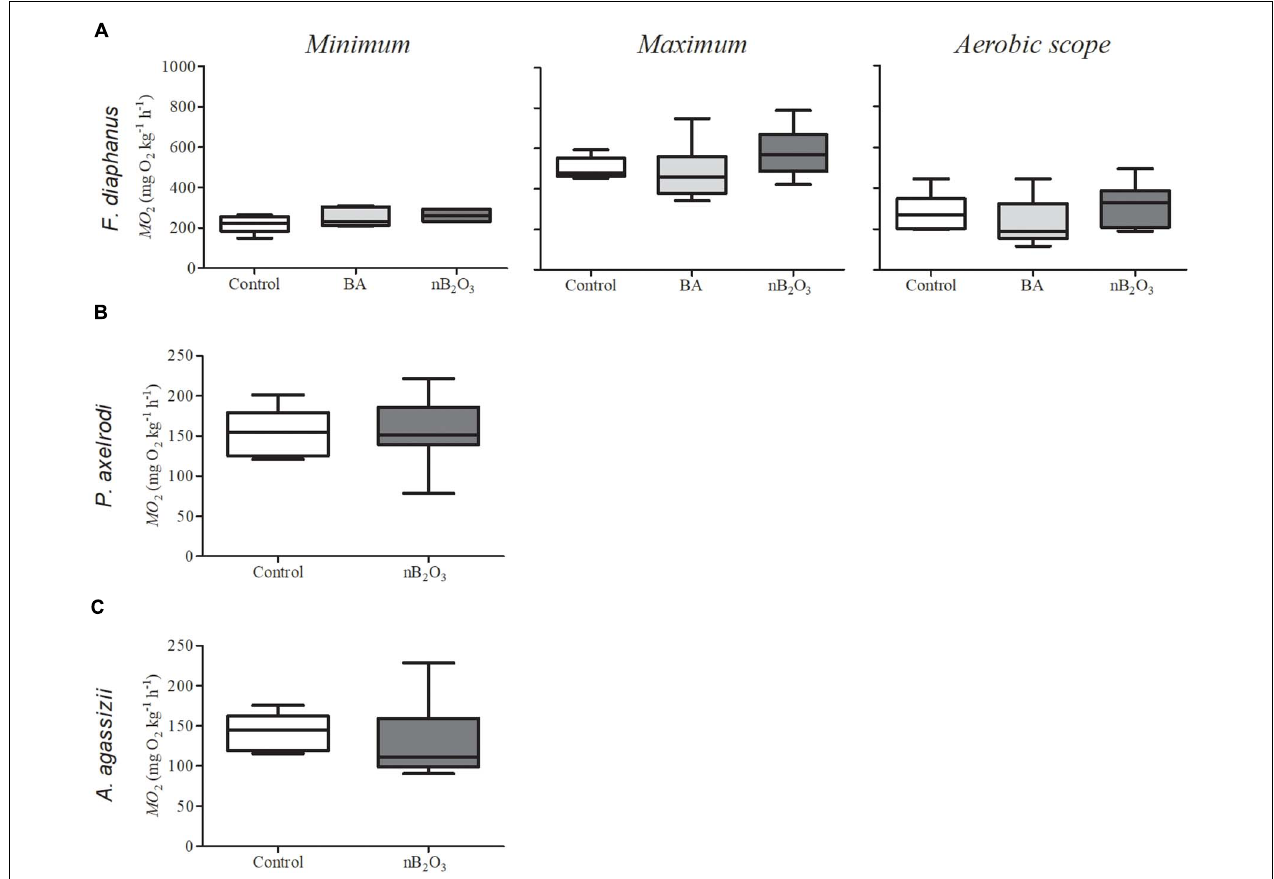
FIGURE 3 | Rates of O 2 consumption ( ˙M O 2 ) in fish exposed for 48 h to boric acid (BA), nB 2 O 3 , or control conditions ( n = 6–9). (A) Minimum and maximum ˙M O 2 and aerobic scope of Fundulus diaphanus exposed to 10 mg L − 1 BA, 1.0 mg L − 1 nB 2 O 3 , or control conditions ( n = 6 for all conditions). (B) Minimum ˙MO 2 in Paracheirodon axelrodi exposed to 10 mg L − 1 nB 2 O 3 or control conditions ( n = 8 for both) and (C) Apistogramma agassizii exposed to 10 mg L − 1 nB 2 O 3 ( n = 9) or control conditions ( n =